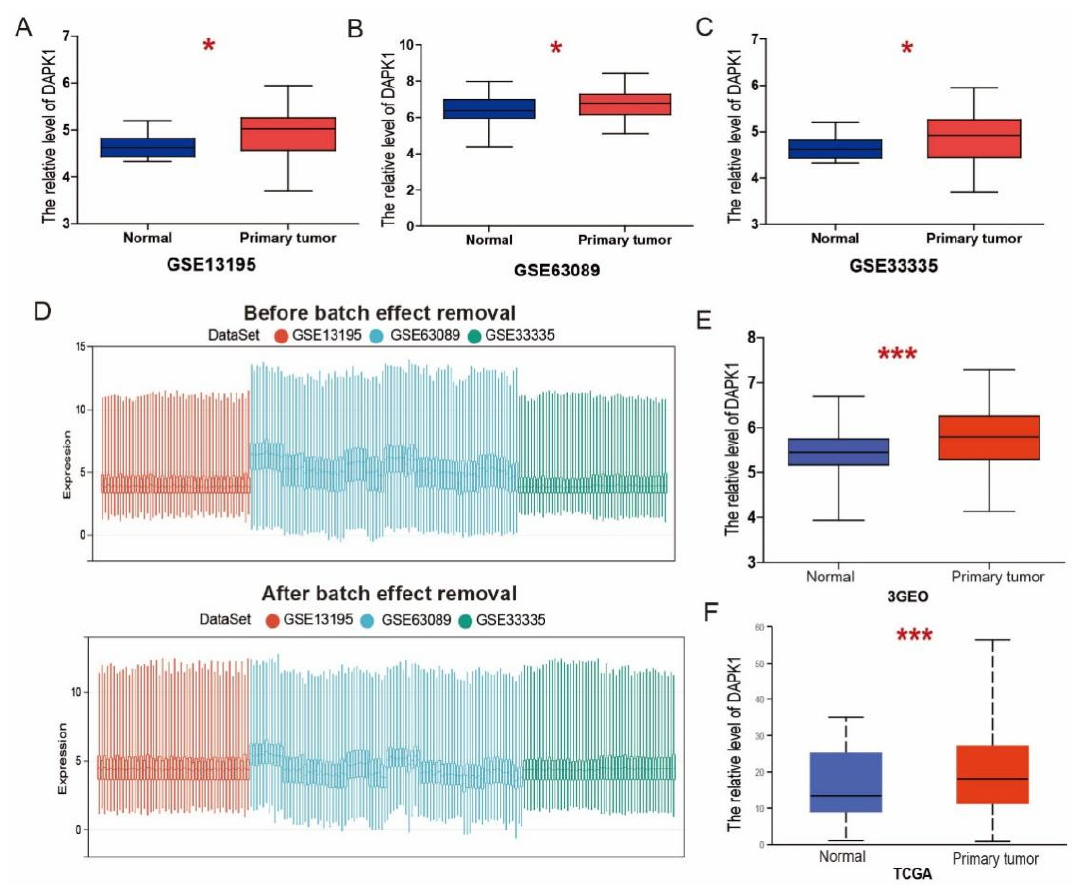
Figure 1. DAPK1 expression in GC. ( A – C ) The expression of DAPK1 in GC based on GSE13195 ( A ), GSE63089 ( B ), and GSE33335 ( C ). ( D ) Boxplots of data distribution before and after batch effect re- moval for GSE13195, GSE63089, and GSE33335 datasets. ( E and F ) The expression of DAPK1 in GC based on 3GEOs ( E ) and TCGA ( F ). * p < 0.05; *** p < 0.001.